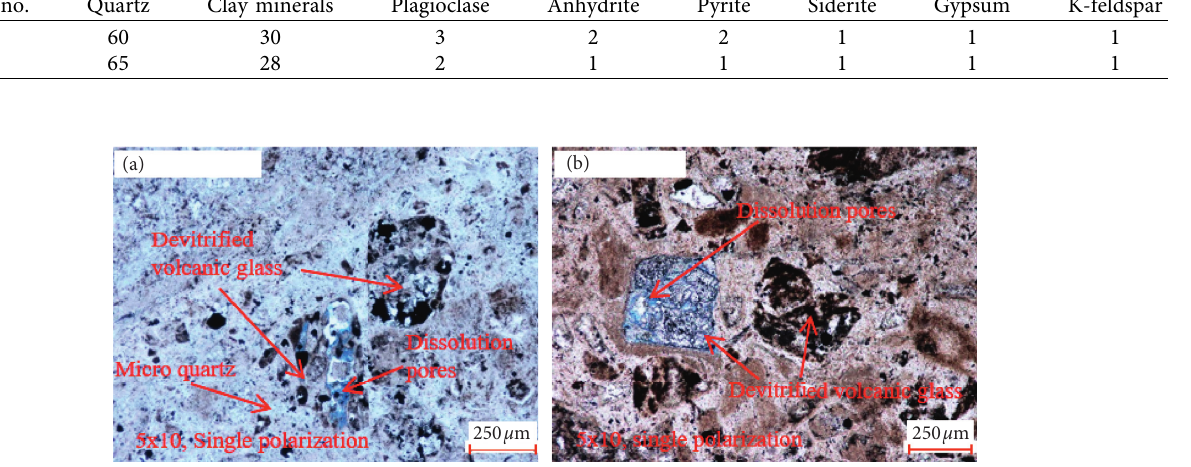
Figure 3: Polarized light microscopy image on the tunnel tuffs of Mila Mountain under dry and saturated conditions. (a) MLS-DRY. (b)